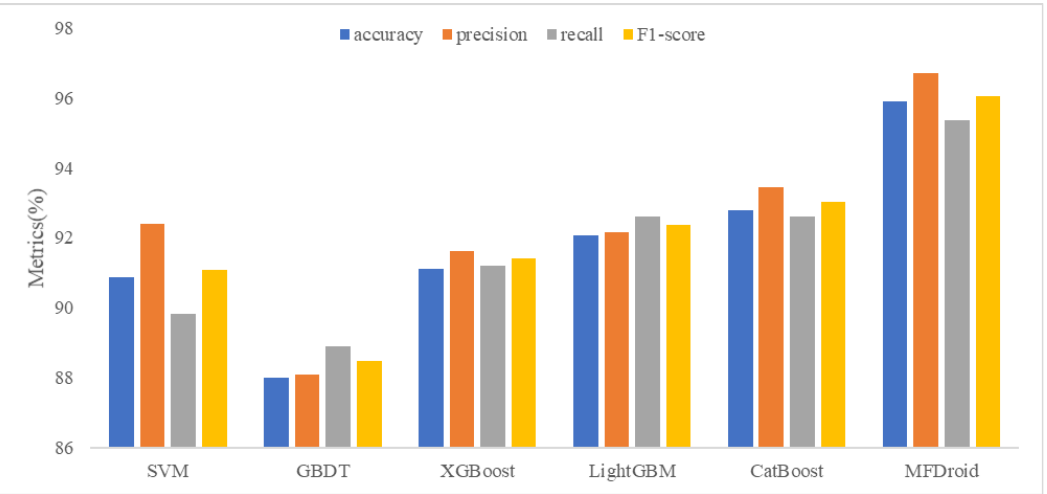
Figure 10. Comparison of results between MFDroid and single classifier. Table 10. Evaluation metrics of MFDroid and single classifier.